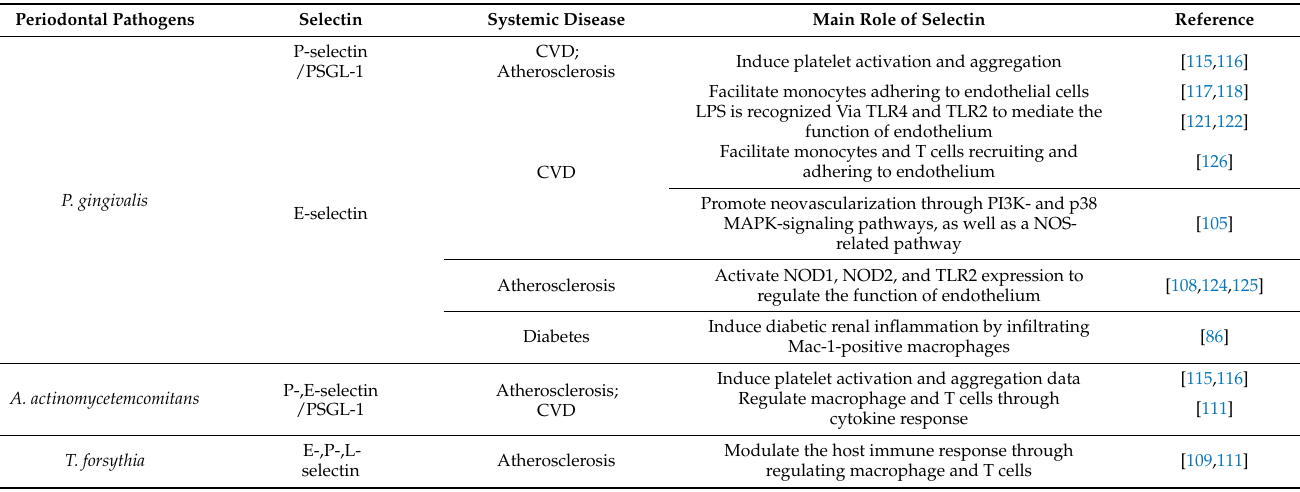
Table 1. The roles of periodontal pathogens and selectins involved in periodontitis associated- systemic